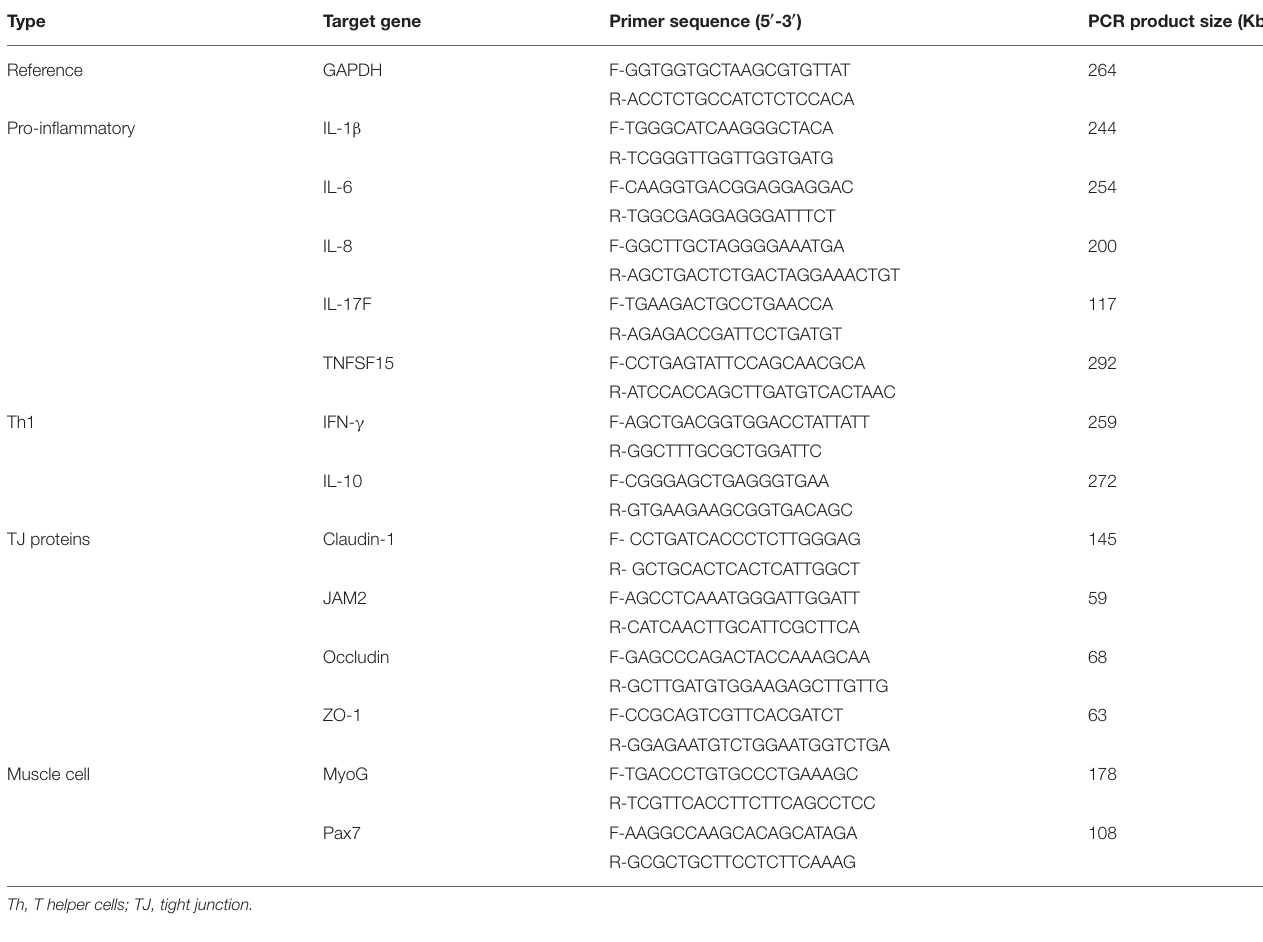
TABLE 1 | Oligonucleotide primer sequences for qRT-PCR.